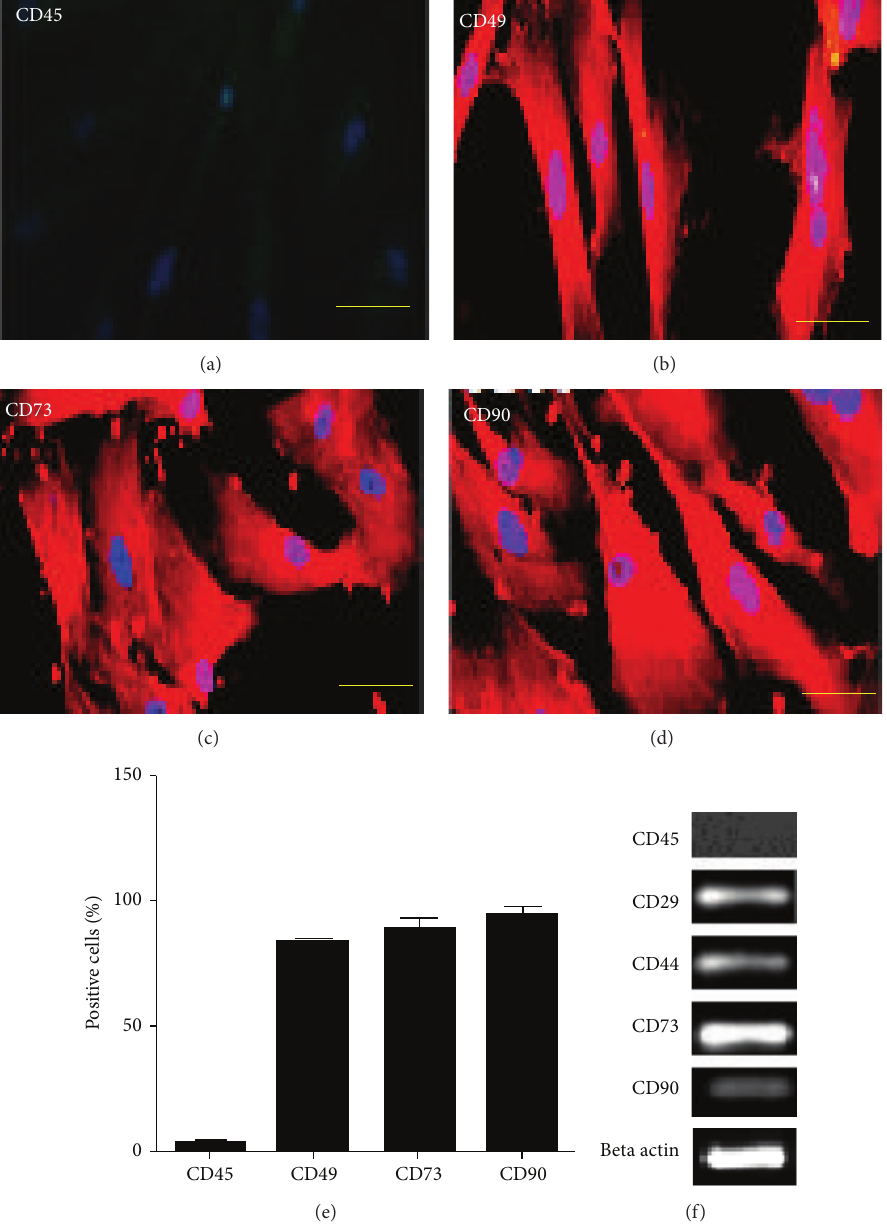
Figure 3: Immunostaining for UC-MSCs; (a) CD 45 negative. (b)–(d) CD49, CD73, and CD90 positive. (e) shows percentage of positive cells. RT-PCR for UC-MSCs; (f) CD29, CD44, CD73, and CD 90